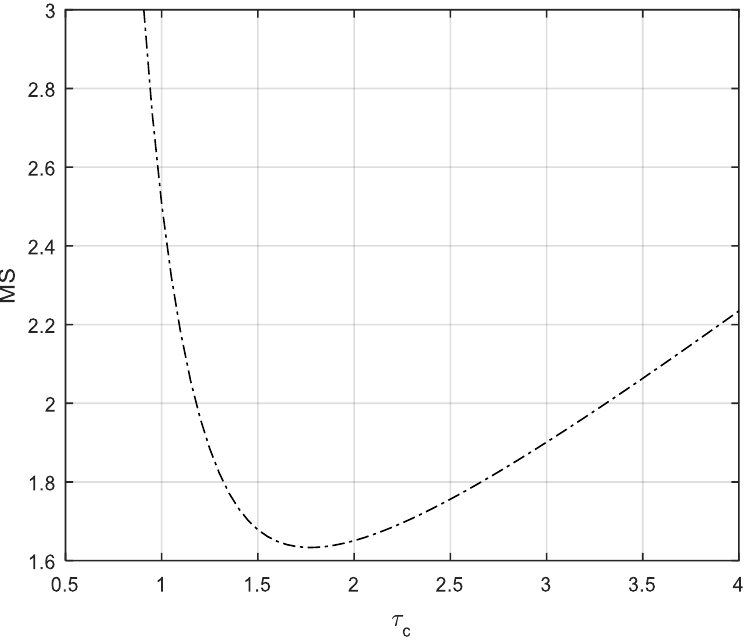
Figure 3. Changes in maximum magnitude of the sensitivity function (MS) for 𝜏 𝑐 in the pure integrating processes with time delays (PIPTD) model .